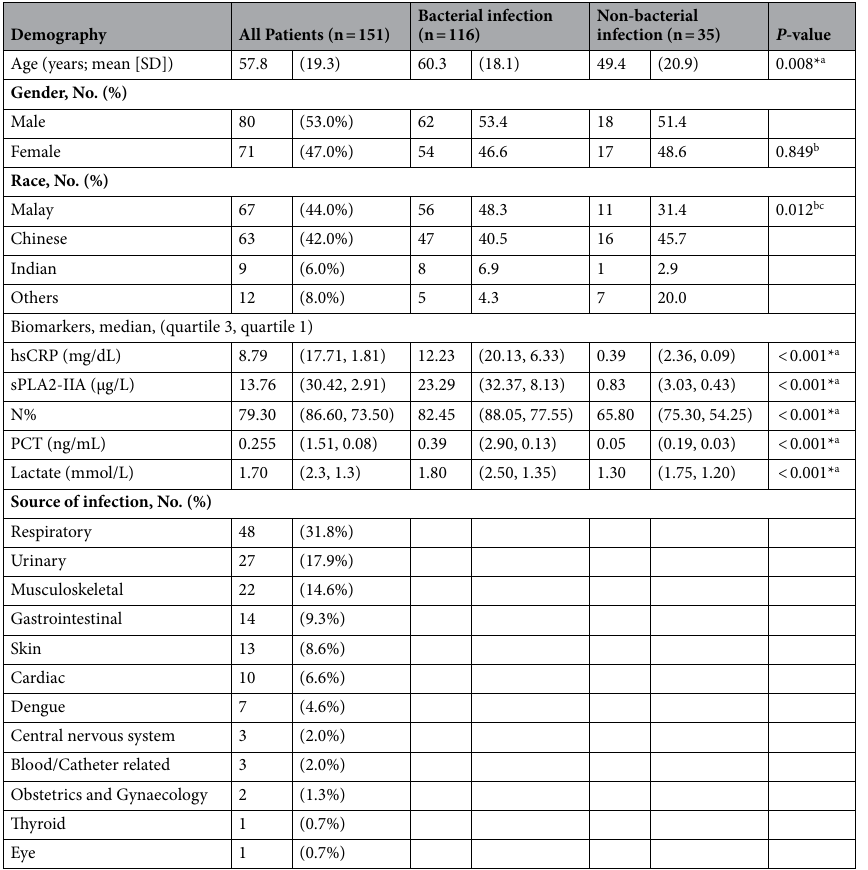
Table 1. Sociodemographic data of patients recruited for the study. hsCRP high-sensitive C-reactive protein, sPLA2-IIA secretory phospholipase 2-IIA, N% neutrophil percentage, PCT procalcitonin. *A 2-sided P value of < 0.05 indicate the statistical significance. *A 2-sided P value of < 0.01 was adjusted for multiple comparisons to indicate the statistical significance based on Bonferroni’s correction. a Mann–Witney U test, b Chi square test. c Bonferroni’s